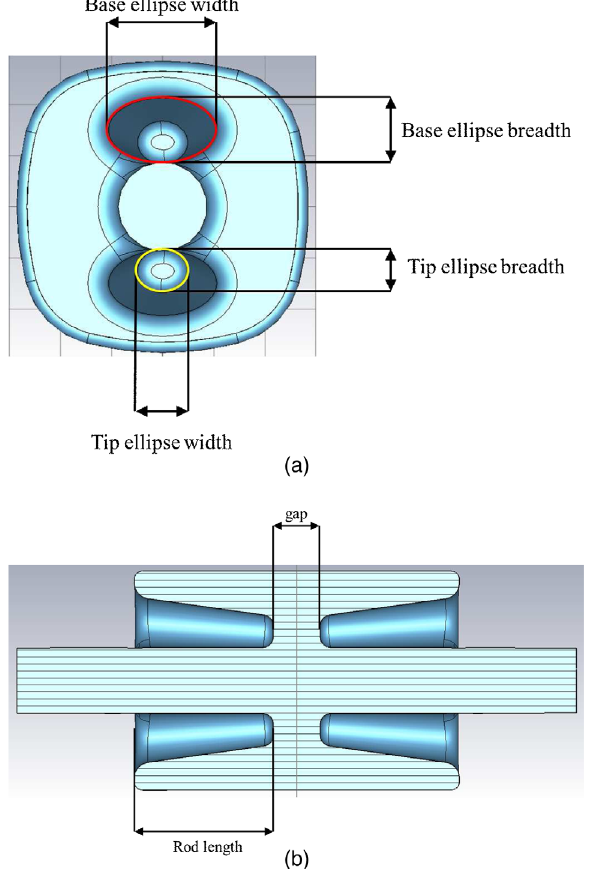
gaps.FIG. 3. Diagrams of the conical elliptical 4RCC, viewed along the beam axis (a) and a transverse cross-section (b) to show the parameterization of the rod design